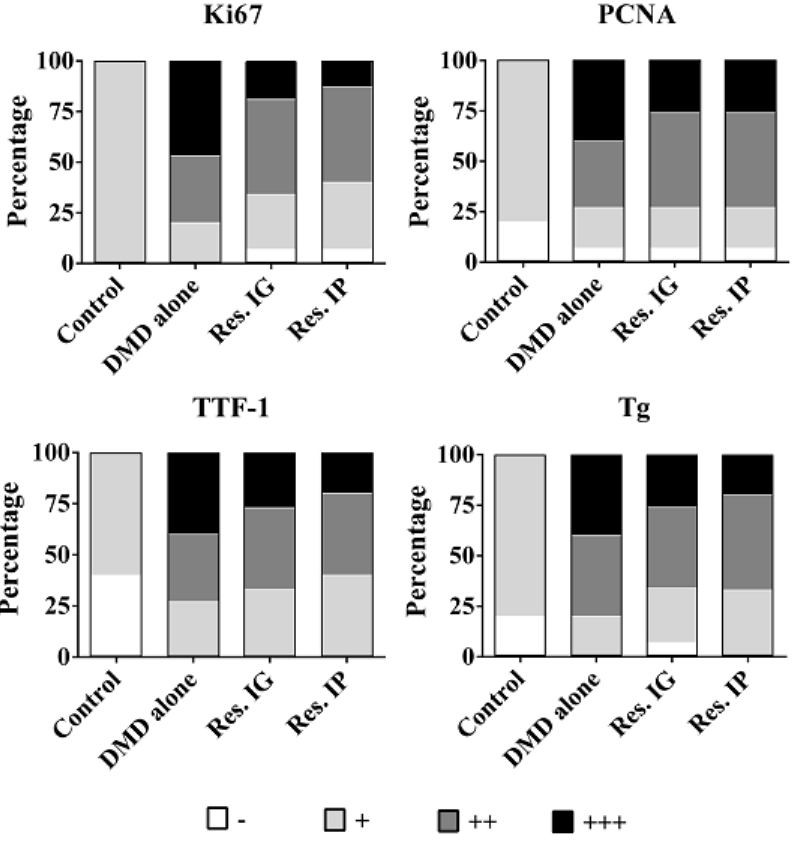
Figure 5. The fractionation of Ki67, PCNA, TTF-1 and Tg expression patterns in the thyroid tissues of the four experimental